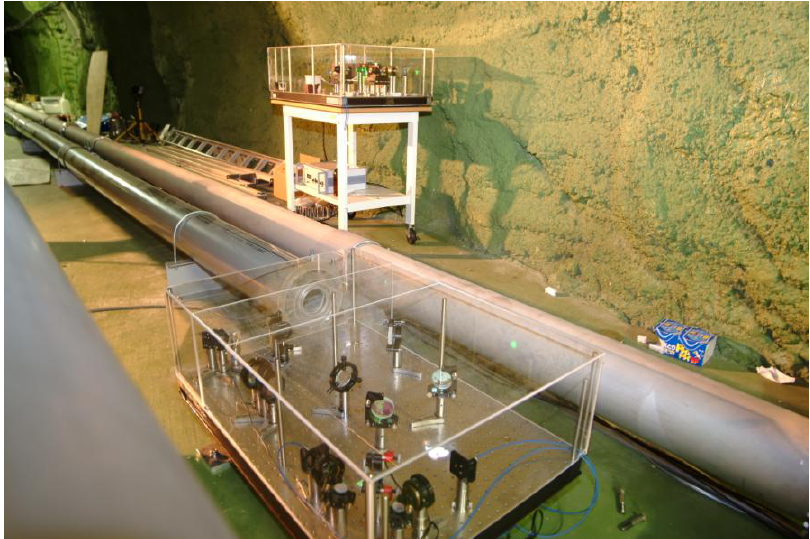
Figure 5. Photograph of setup used for observations. The interferometer part of the 70 m two-color interferometer is set on the front optical table. The light source of the two-color interferometer is set on the back optical table. A PVC pipe extends from the front optical table. The pipe behind the PVC pipe is a vacuum pipe for the 100 m strainmeter.